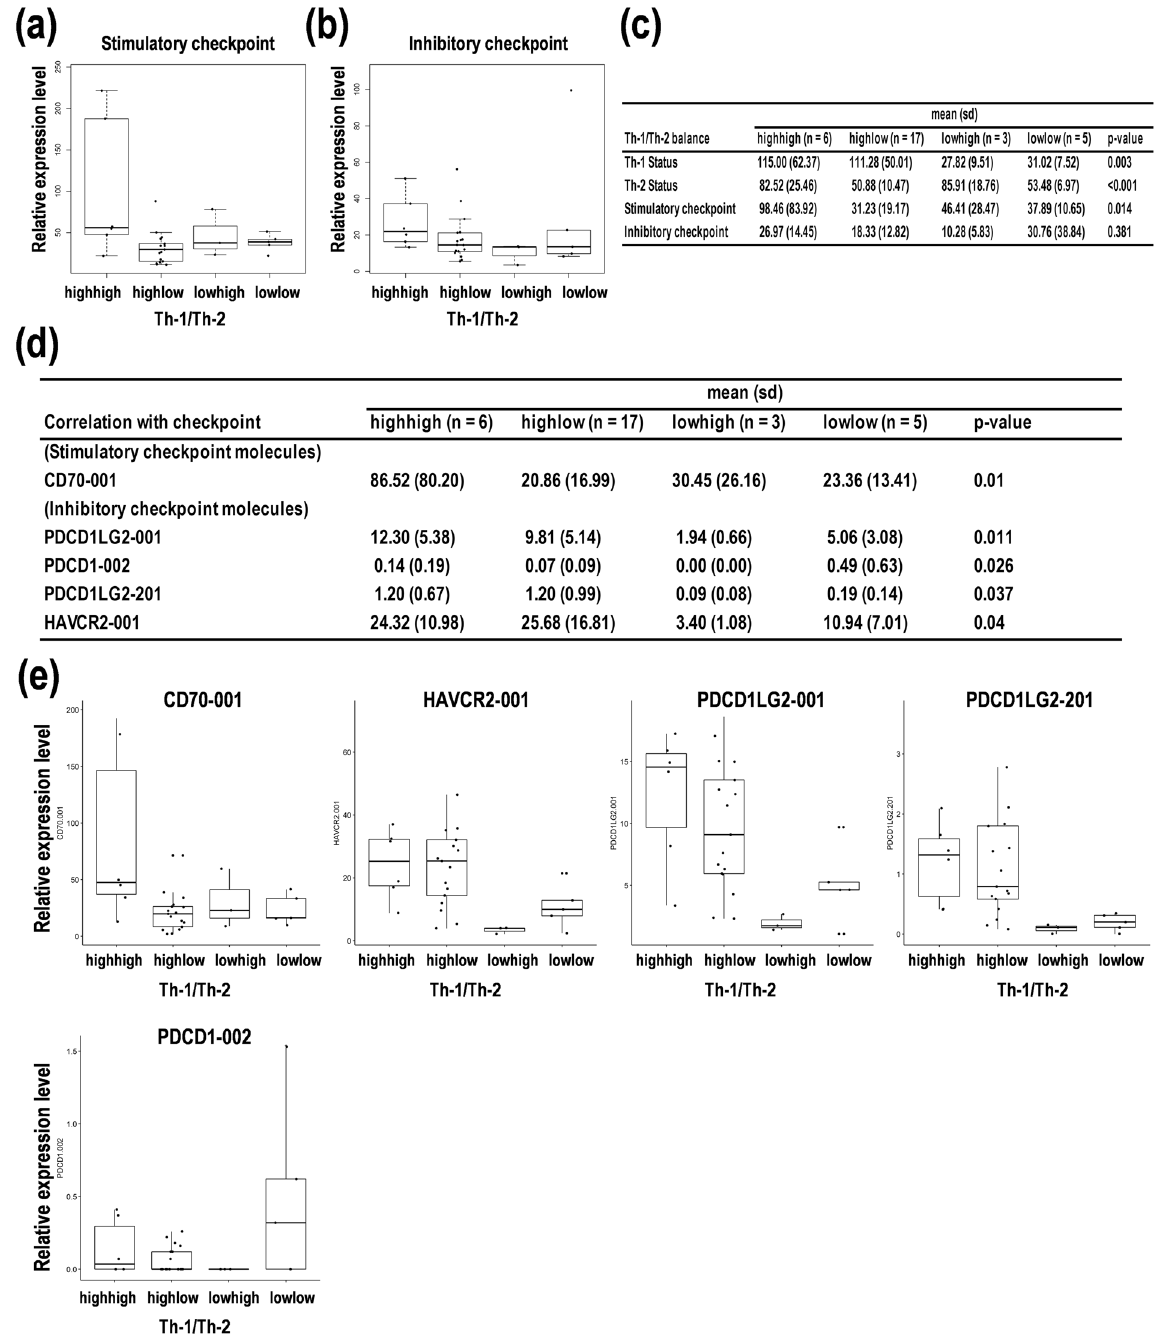
Figure 4. Comparative expression analysis of immune checkpoint-related genes on the balance of T helper cell type 1/2 (Th-1/Th-2) status in primary central nervous system lymphoma (PCNSL). ( a , b ) Relative expression patterns of immune checkpoint-related genes based on the balance of Th-1/Th-2 status. ( a ) Stimulatory checkpoint. ( b ) Inhibitory checkpoint. ( c ) Statistics for the four subgroups defined as Th-1 high Th-2 high , Th- 1 high Th-2 low , Th-1 low Th-2 high , and Th-1 low Th-2 low . The p-value indicates one-way analysis of variance (ANOVA). ( d ) Statistics for the differential expression of the genes on the four groups. The p-value indicates one-way ANOVA. ( e ) The box-whisker plots of the expression of stimulatory and inhibitory immune checkpoint genes. The PCNSL patients were divided into four subgroups including Th-1 high Th-2 high , Th-1 high Th-2 low , Th-1 low Th- 2 high , and Th-1 low Th-2 low